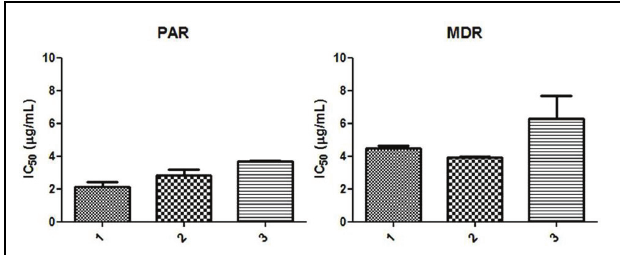
FIGURE 5 | Cytotoxic effects of dimeric naphthoquinones on PAR and MDR mouse. T-cell lymphoma cell lines. The mean IC 50 was calculated on the basis of the results of three independent experiments. SEM, standard error of the mean.